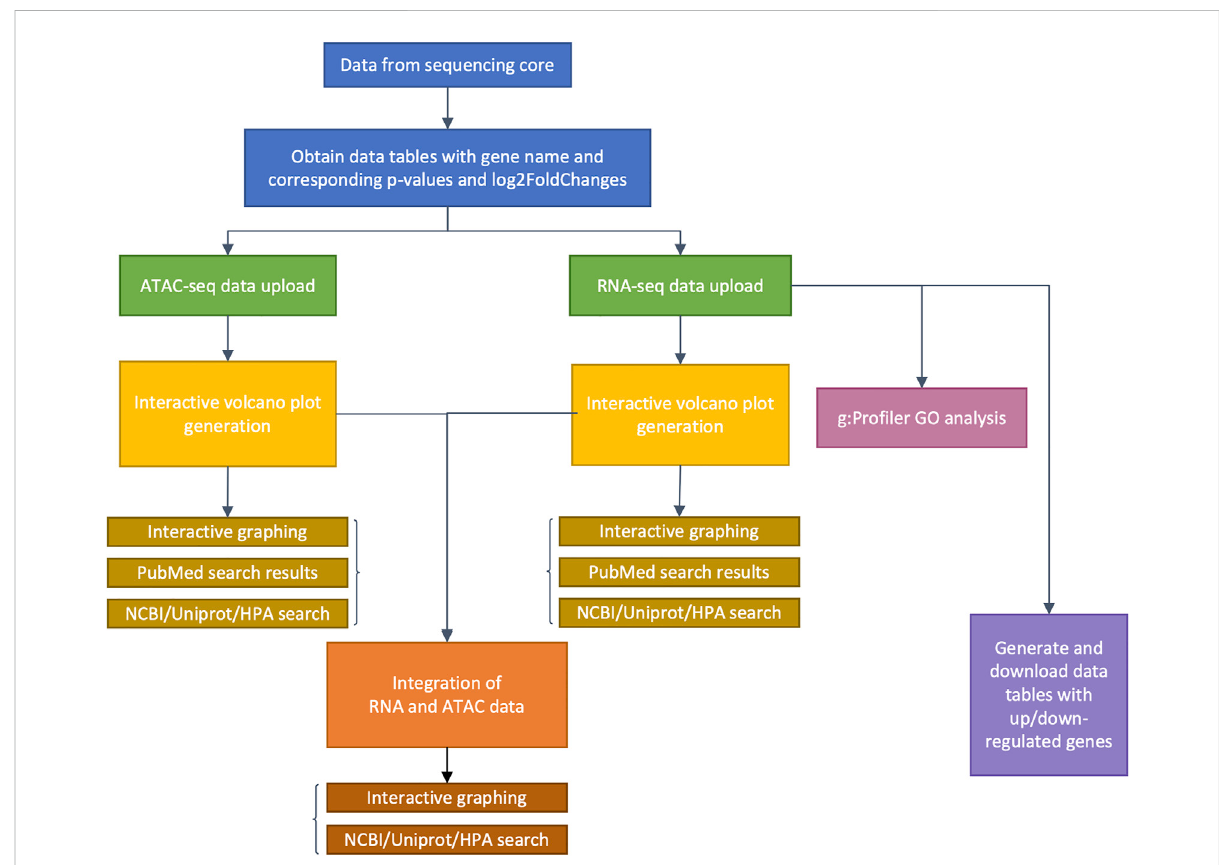
FIGURE 1 Flow chart detailing genomeSidekick functionalities.Afterrawsequencingdata is obtained from thesequencing core, alignment, and statistical analyses on genes or chromatin features should be performed by a bioinformatician, with at least three columns as a result: feature name, adjusted p -values, and log2FoldChange (blue boxes). Then, genomeSidekick users can upload these data tables (.csv or tab-delimited fi les) as inputs to their corresponding tabs within the Shiny app (green boxes), which will contain functions for generation of independent interactive volcano plots (yellow boxes) as well as integrated ATAC-seq and RNA-seq graphs (orange boxes), for example. Note that in addition to ATAC-seq, users may analyze ChIP-seq and other epigenomics data inputs containing p -values and log2FoldChanges. Uploading an RNA-seq data set will also allow the application to perform g:Pro fi ler GO analysis (magenta box) and generate downloadable lists of up- and downregulated genes (purple box). HPA: Human Protein